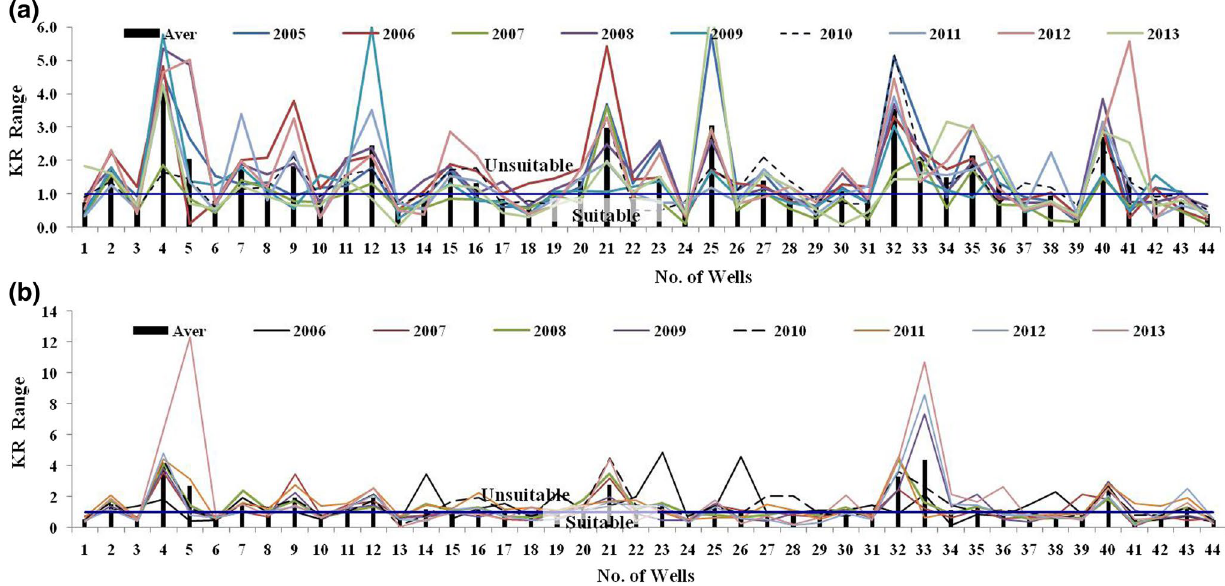
Fig. 5 a Nine-year (2005–2013) temporal representation KR/KI value during pre-monsoon. b Nine-year (2006–2013) temporal representation KR/KI value during